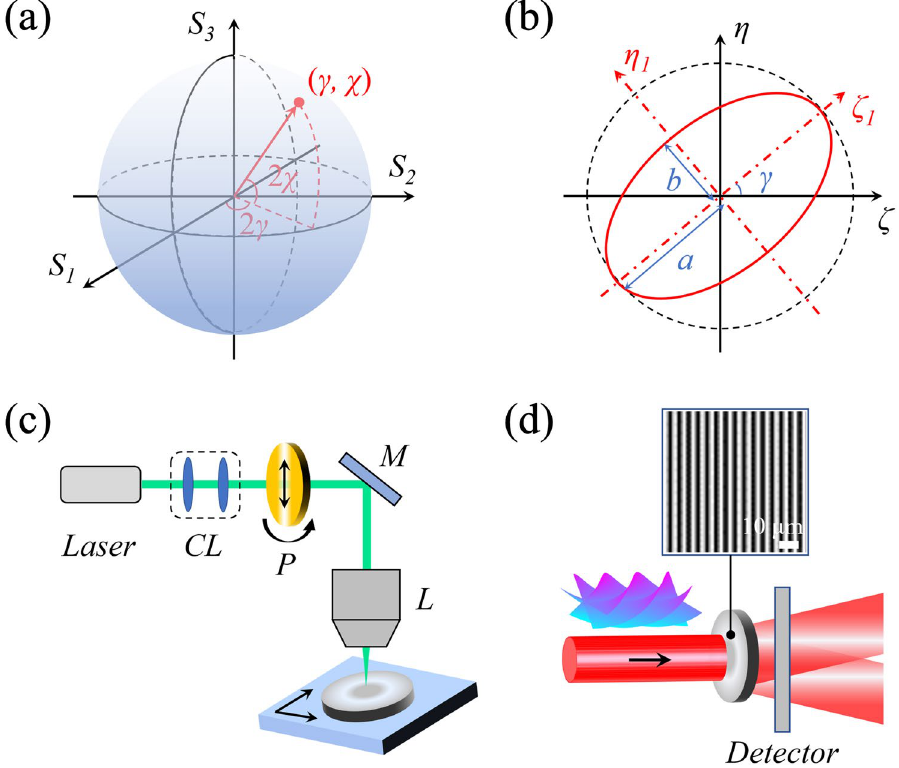
Figure 1. ( a ) Representation of optical polarization states on the Poincaré sphere. γ and χ represent the polarization direction and ellipticity, respectively. S 1 – S 3 are the Stokes parameters. ( b ) Two-dimensional representation of polarization states through polarization ellipse. ( c ) Schematic of direct-writing fabrication of the designed broadband geometric-phase waveplate with the thickness of 1 μm. CL collimating lenses, P controlled linear polarizer, M mirror, L lens. ( d ) Experimental setup for efficient vortex detection using a single geometric-phase waveplate. The designed birefringence structure of the sample is detected experimentally with a polarized optical